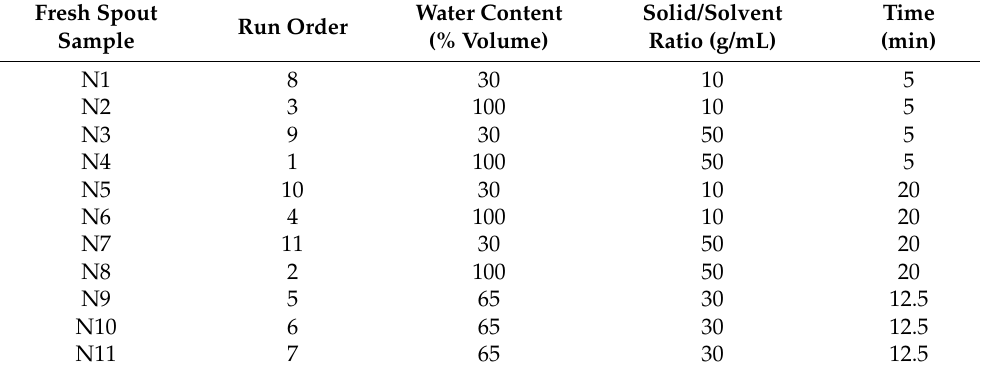
Scheme 1. Experimental design: independent variables for UAE